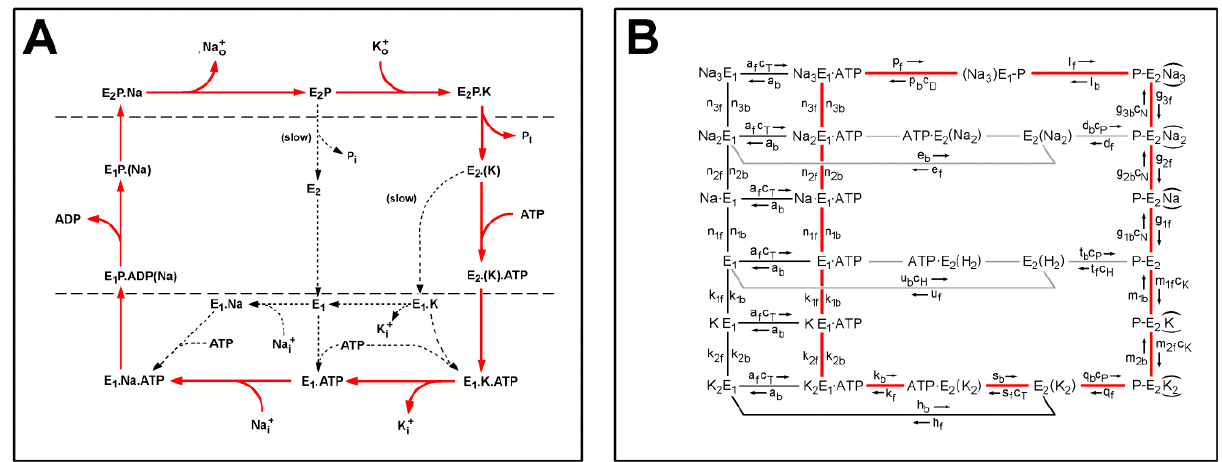
Figure 2: Development of the Post-Albers cycle with enhanced complexity provoked by increasing experimental insights. A: Inclusion of Na + and K + occluded states, indicated by framing the ions in parentheses, (Na) and (K). This scheme was adapted from Karlish and col- laborators. 11 B: Pump scheme composed of all reaction steps that were determined experimentally from rabbit kidney ATPase until 1994, and which was used for successful numerical simulations of the experimental results. 12 The cycles drawn in red represent the physiological pump